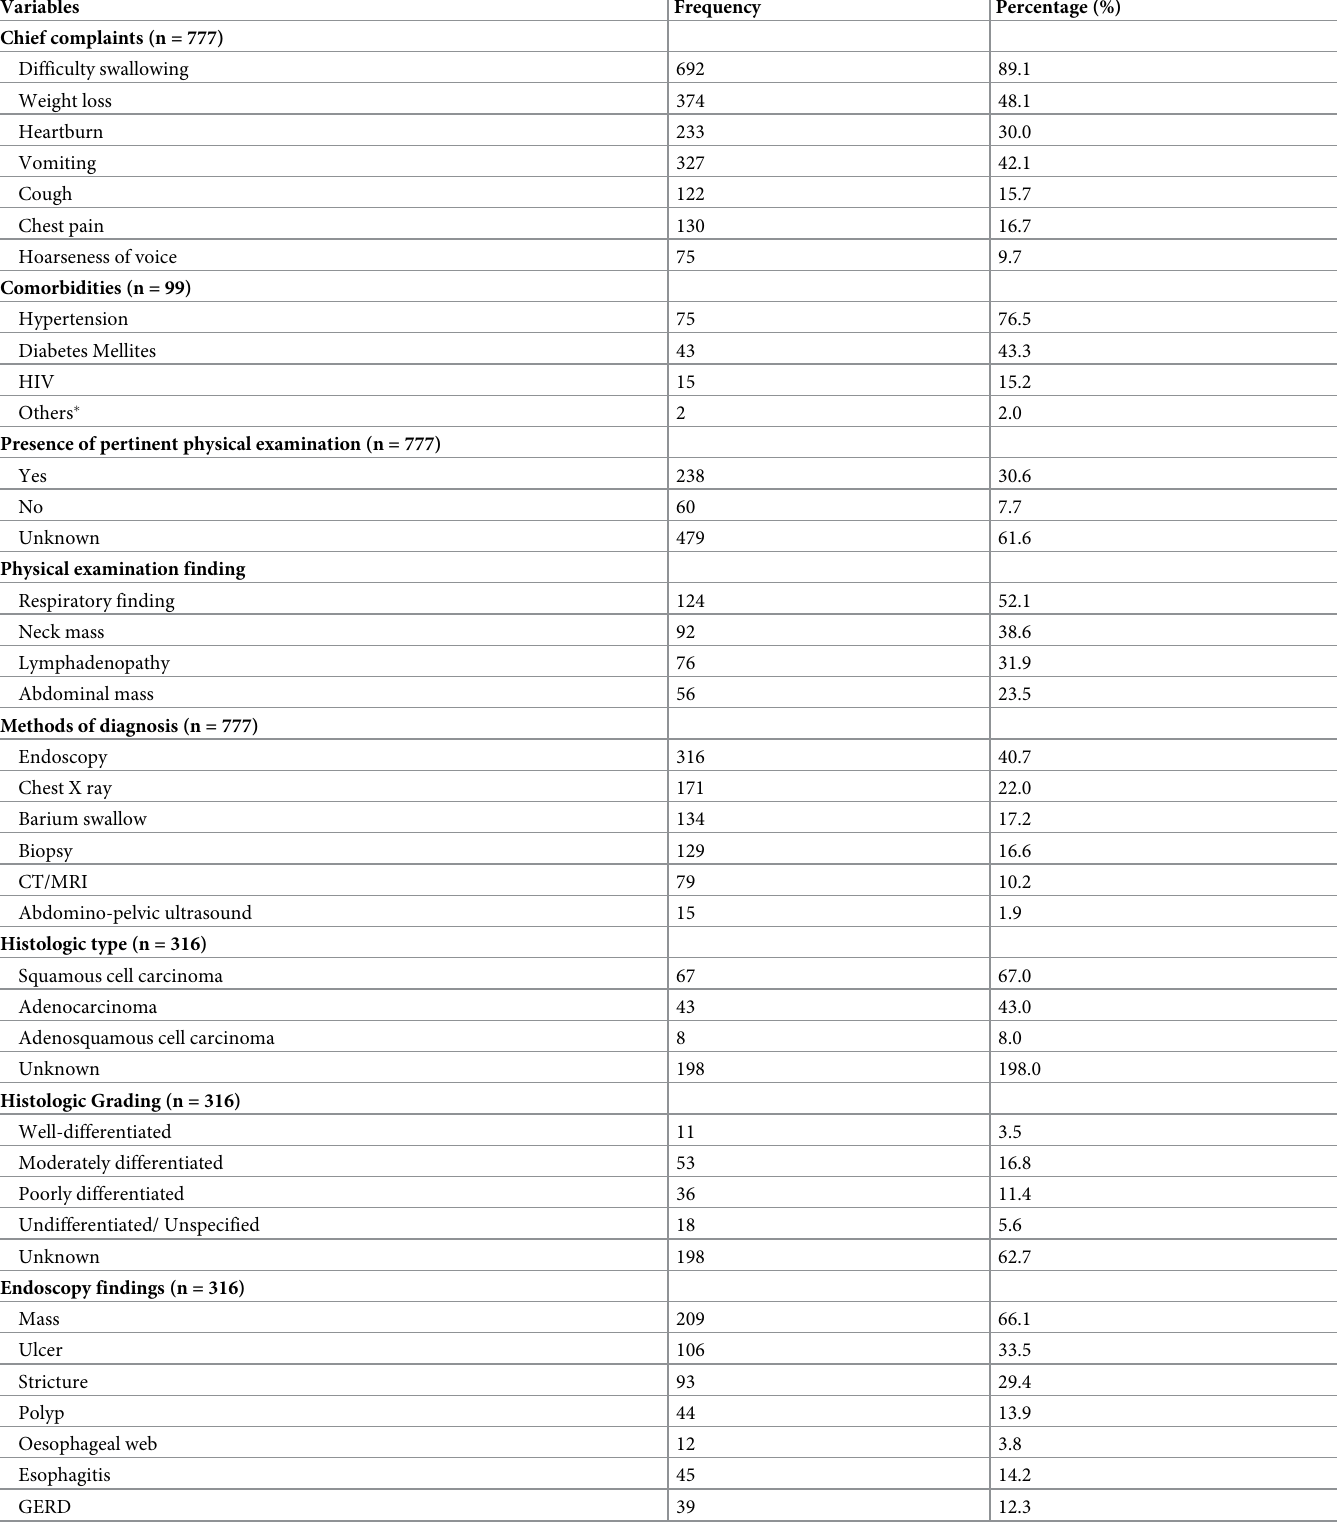
Table 2. Medical and clinical characteristics of oesophageal cancer patients in selected hospitals, Ethiopia,